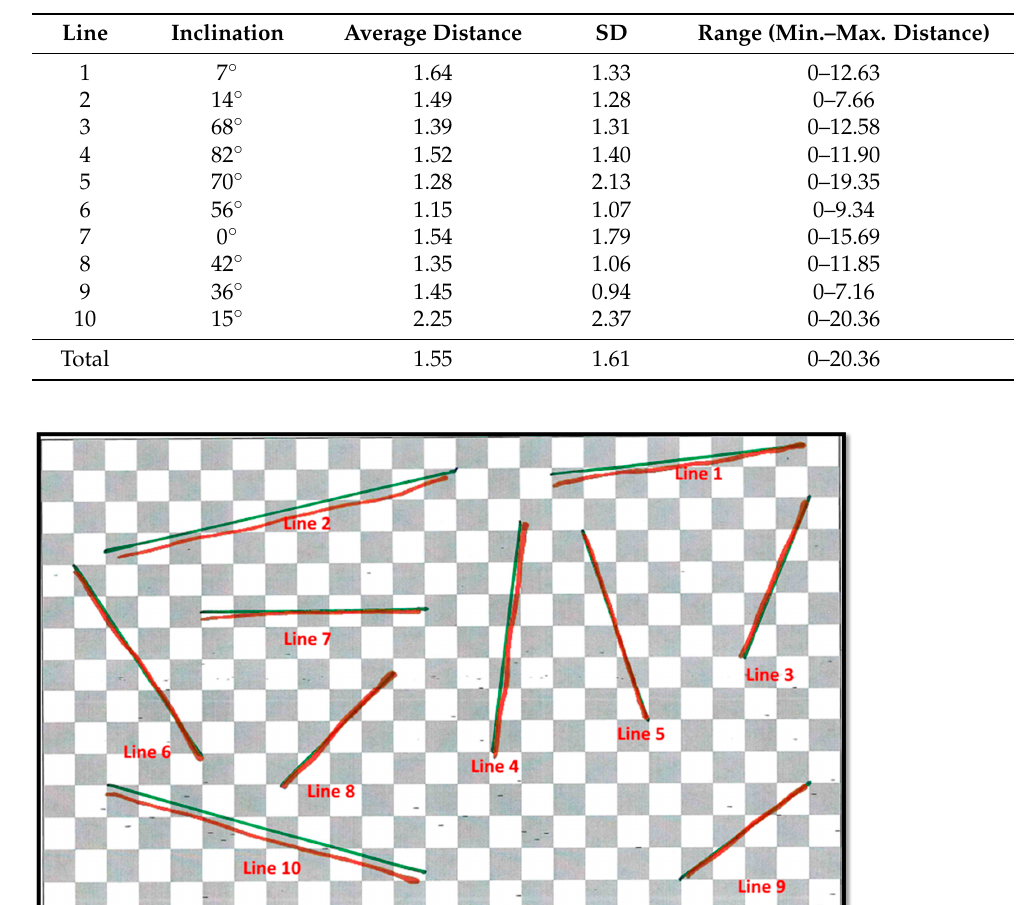
Table 1. Result of annotation accuracy testing presented in average distance, SD and range from minimal to maximal. The unit is millimeter.